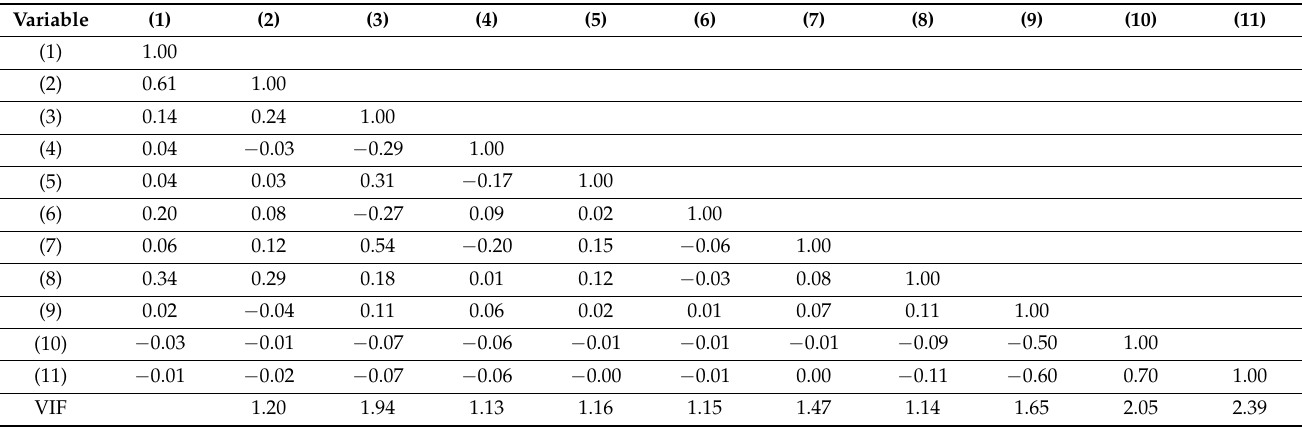
Table 5. Correlation matrix and VIFs of main